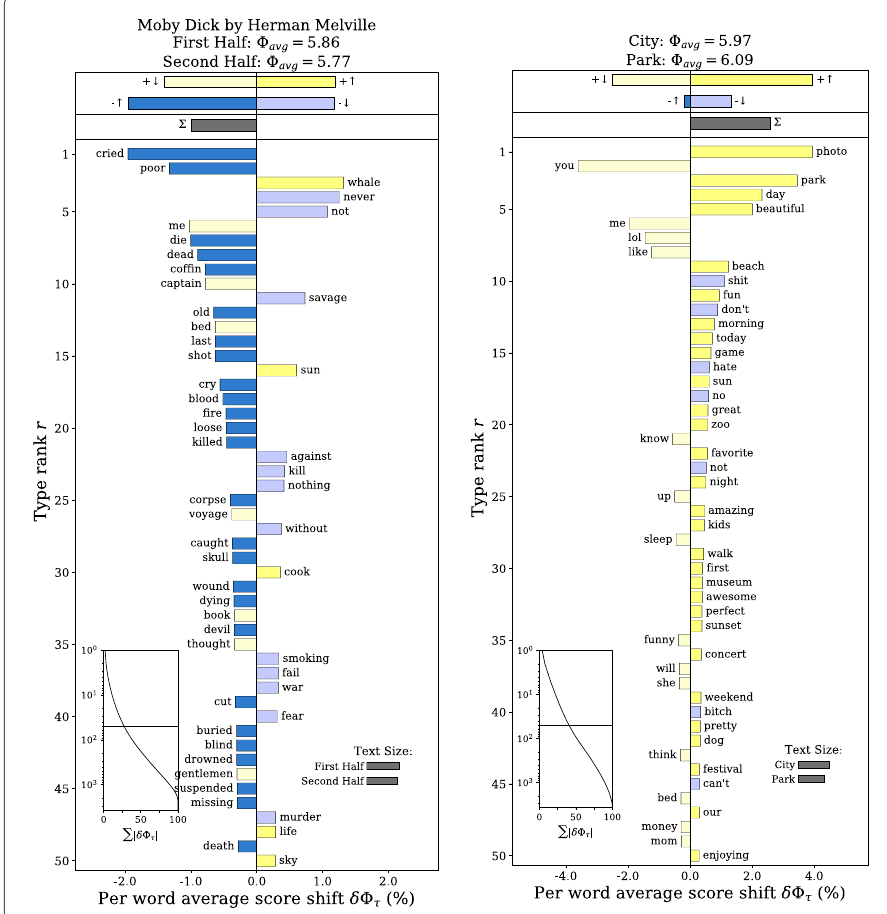
Figure 3 ( Left ) Word shift graph of the sentiment difference between the first and second halves of MobyDick by Herman Melville. A naive application of a dictionary-based sentiment lexicon for the two-segment emotional arc would inflate the negative trajectory of the novel without the preprocessing or removal of words like ‘cried’ and ‘cry’, which more often means ‘said’ in nineteenth century English, and ‘coffin’, which is used as a surname about one third of the time. We find that δ(cid:6) = 0.09 when including those words, while δ(cid:6) = 0.07 when they are excluded. ( Right ) Word shift graph of the sentiment difference between the in-park and out-of-park tweets across 25 cities in the US. A naive application of a dictionary-based sentiment lexicon would inflate the in-park tweet scores by including words like ‘park’, ‘beach’, ‘zoo’, ‘museum’, ‘music’, and ‘festival’, all of which represent physical locations and events within parks. We find that δ(cid:6) = 0.12 when including those words, while δ(cid:6) = 0.10 when they are excluded. For both word shift graphs, a reference value of 5 was used, and a stop lens was applied on all words with a sentiment score between 4 and 6. Both word shift graphs contain cumulative contribution and text size diagnostic plots in their bottom left and right corners, respectively. See the following case study and the Materials and methods for more details on their